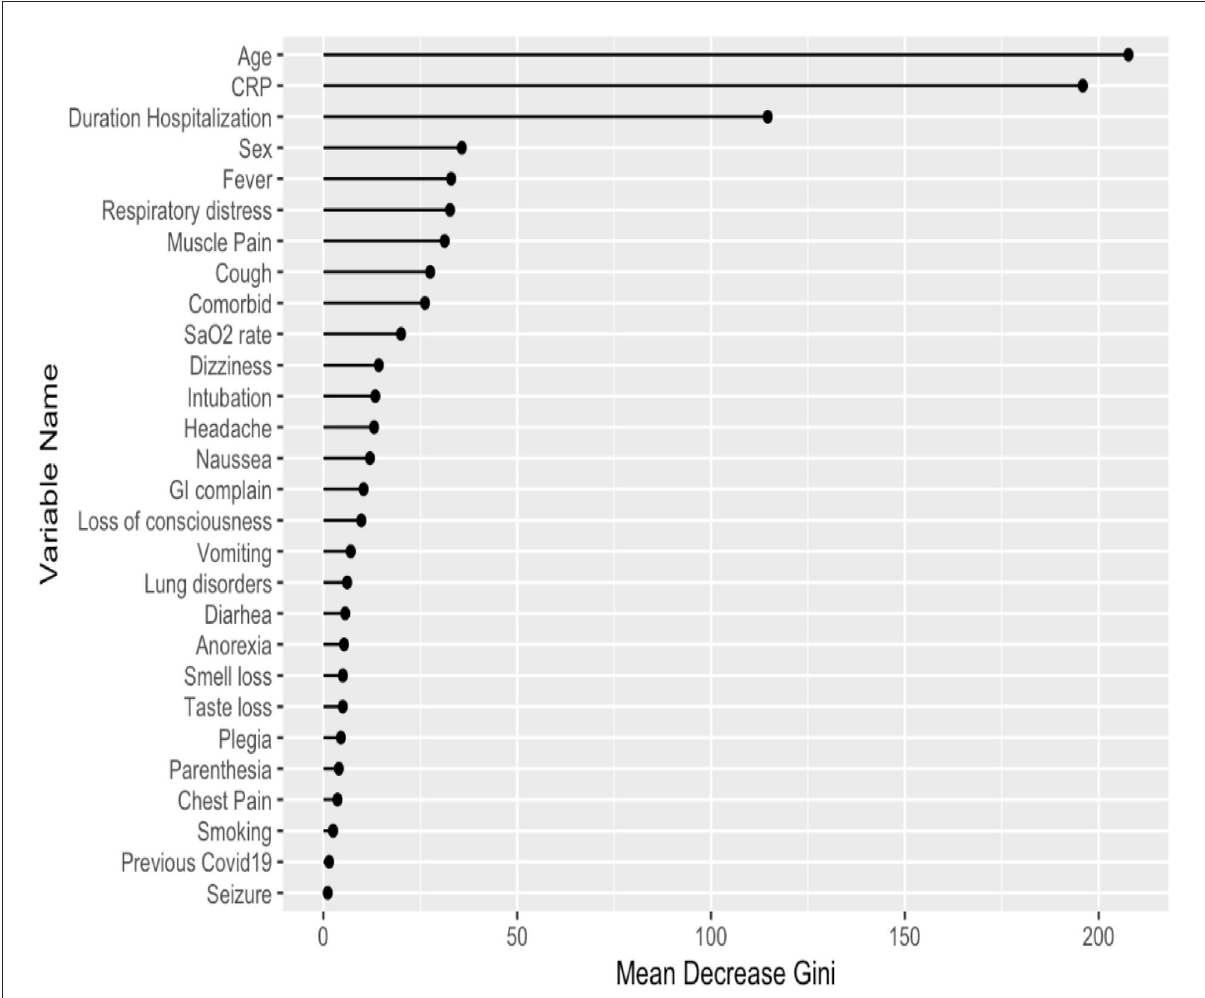
FIGURE2 Predictors of lung involvement severity in hospitalized patients with COVID-19 infection in the training dataset. CRP, C reactive protein; GI,